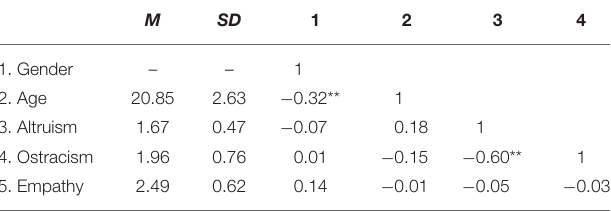
TABLE 1 | Means and standard deviations of the variables in study